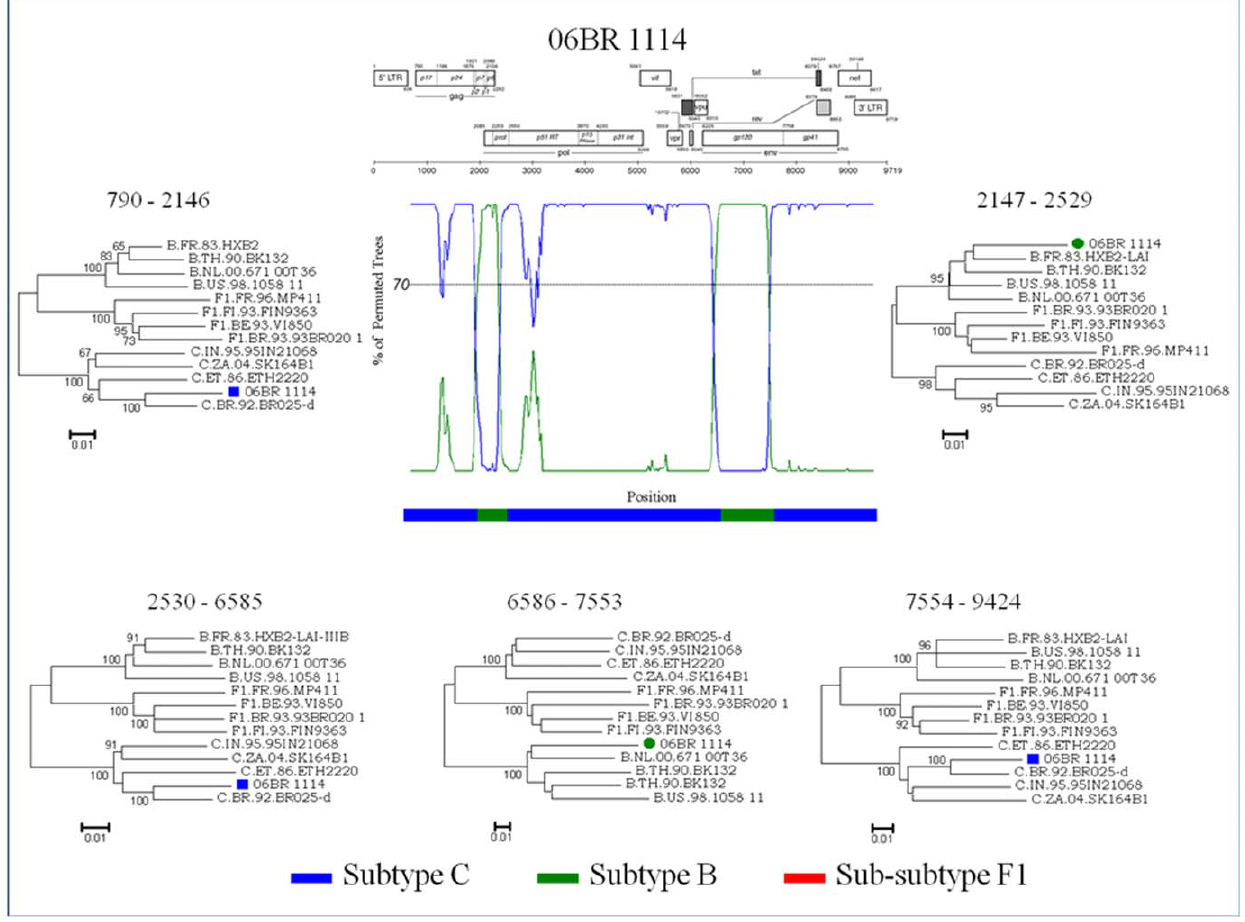
Figure 5. Exploratory tree analysis based on fragments between breakpoints as indicated by bootscan plot of isolate 06BR 1114. Annotation of samples is as follows: symbol-green circle (subtype B), symbol-blue square (subtype C). The approximate likelihood ratio test (aLRT) values of $ 90% are indicated at nodes. The scale bar represents 0.01 nucleotide substitutions per site. The region of subtype C, subtypes B, and subclade F1 are indicated at the bottom. doi:10.1371/journal.pone.0025869.g005 Table 3. Drug-resistance mutations detected in antiretroviral (ARV) naı¨ve patients.